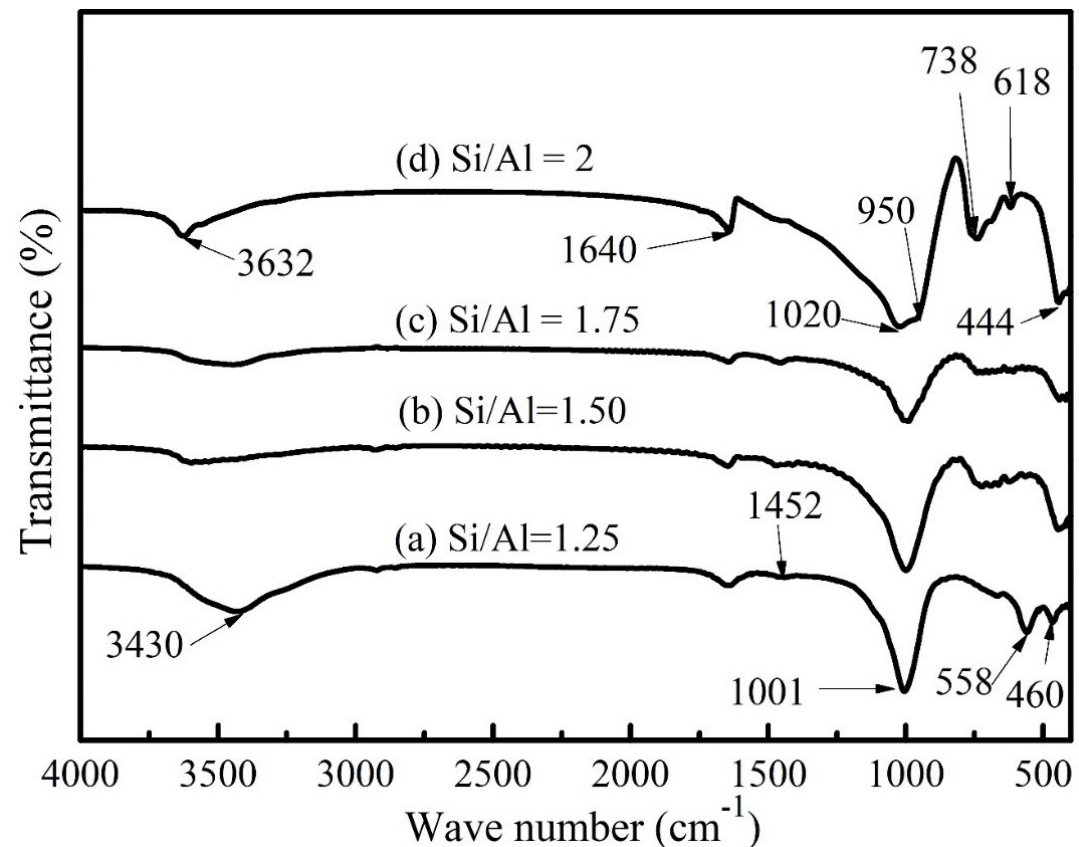
Figure 7. FTIR results of specimens after hydrothermal treatment with various Si/Al molar ratios.